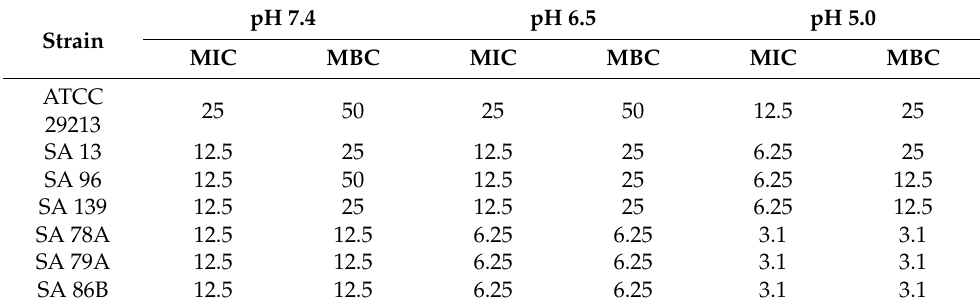
Table 3. The MIC (minimum inhibitory concentration) and MBC (minimum bactericidal concen- tration) in μ L/mL of each strain analyzed at pH 7.4, 6.5, and 5.0.